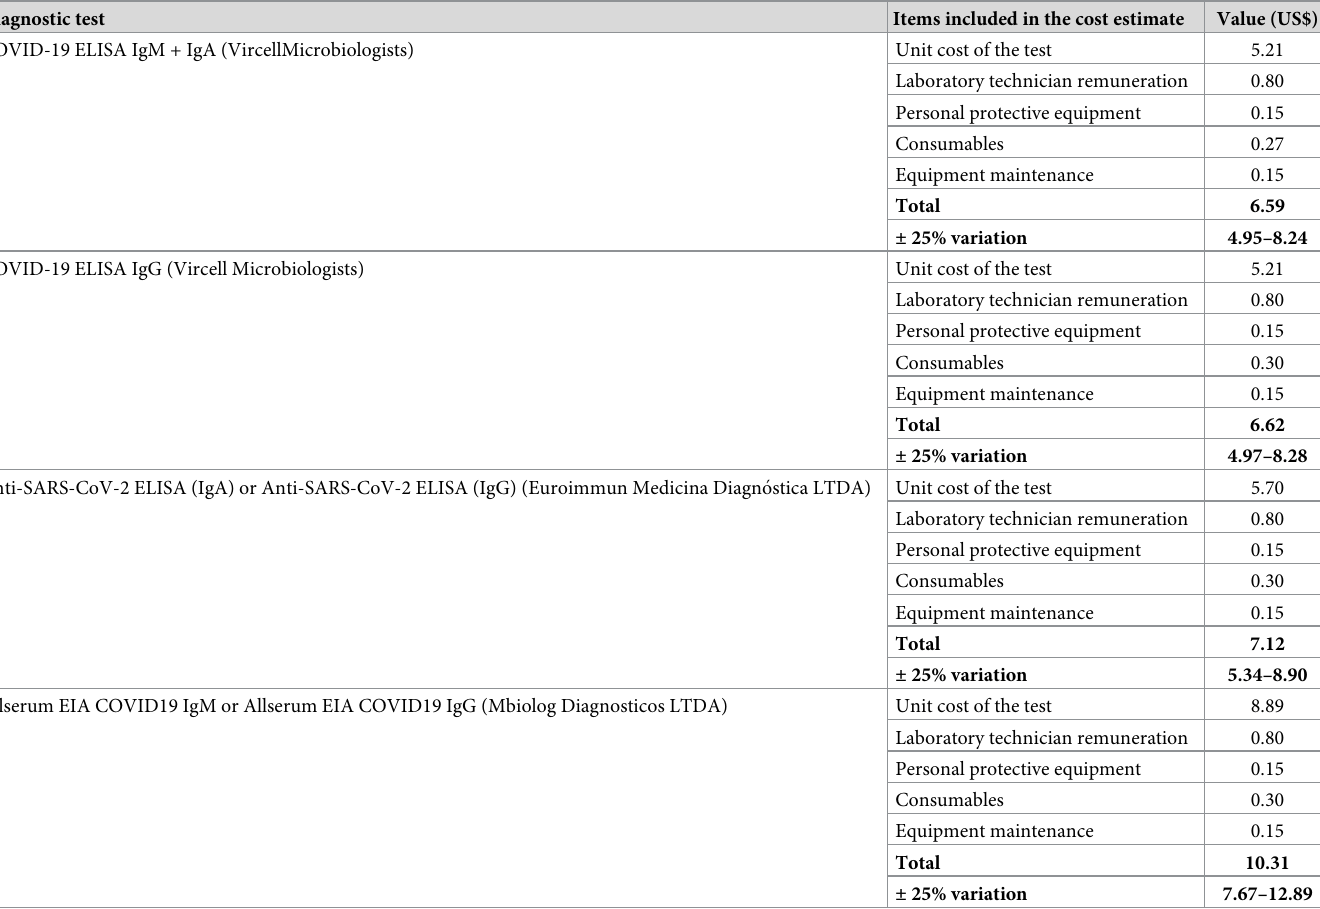
Table 3. Detailed cost of the items included in the direct cost estimates of the evaluated immunoenzymatic assays for COVID-19 in Brazil, base year